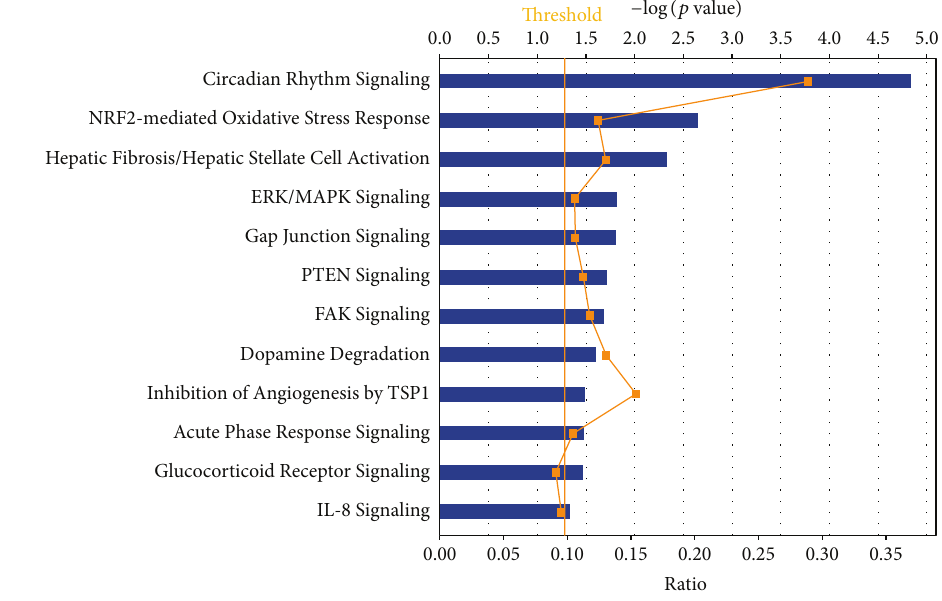
Figure 2: Top canonical pathways for both day 07 and day 30, ANOVA ( 𝑝 < 0.01 ). Table 1: Circadian Rhythm Signaling genes from Ingenuity Pathway Analysis